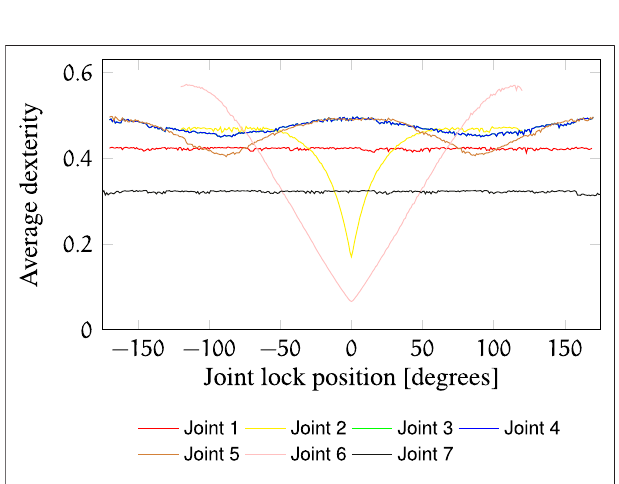
FIGURE 8 | Post-failure average dexterity in W j , l as a function of l . The average dexterity for the nominal failure-free workspace is